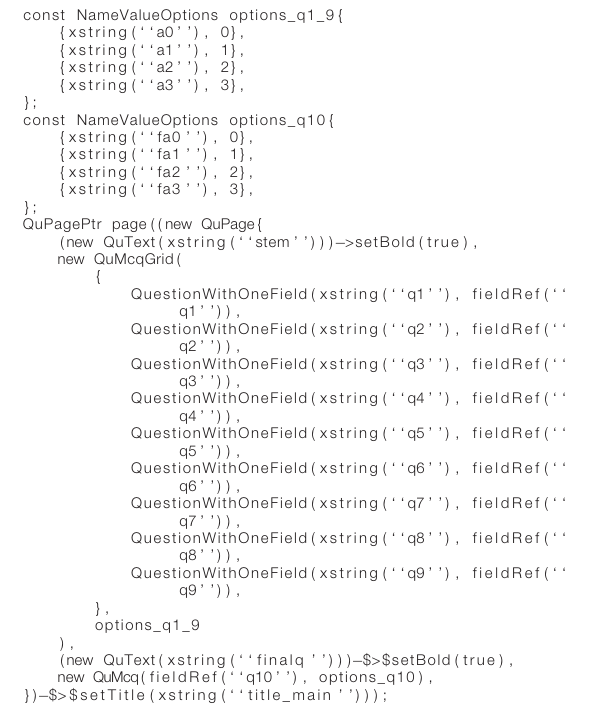
BOX 1 | C ++ code snippet illustrating the core of the implementation of a questionnaire-style task, the PHQ-9 (2), within the CamCOPS client app. This task uses some static text, a grid-style set of multiple-choice questions(MCQs)forquestions1–9thatallshareasetofanswersmapped to the data values 0–3, and a single MCQ for question 10. Calls to the xstring() function yield internationalized (language-/locale-specific) task strings; for example, xstring(“q1”) in the English locale evaluates to “1. Little interest or pleasure in doing things,” while xstring(“a3”) evaluates to “Nearly every day.” See Figure 3A for the resulting